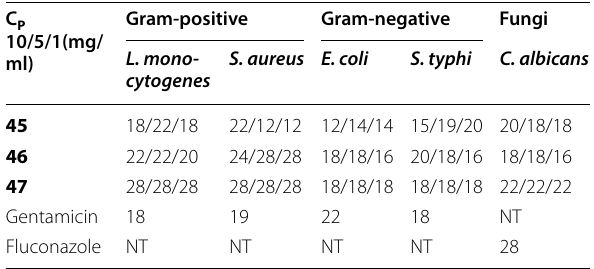
Table 14 Antimicrobial activity of 5-(chromene-3-yl)meth-